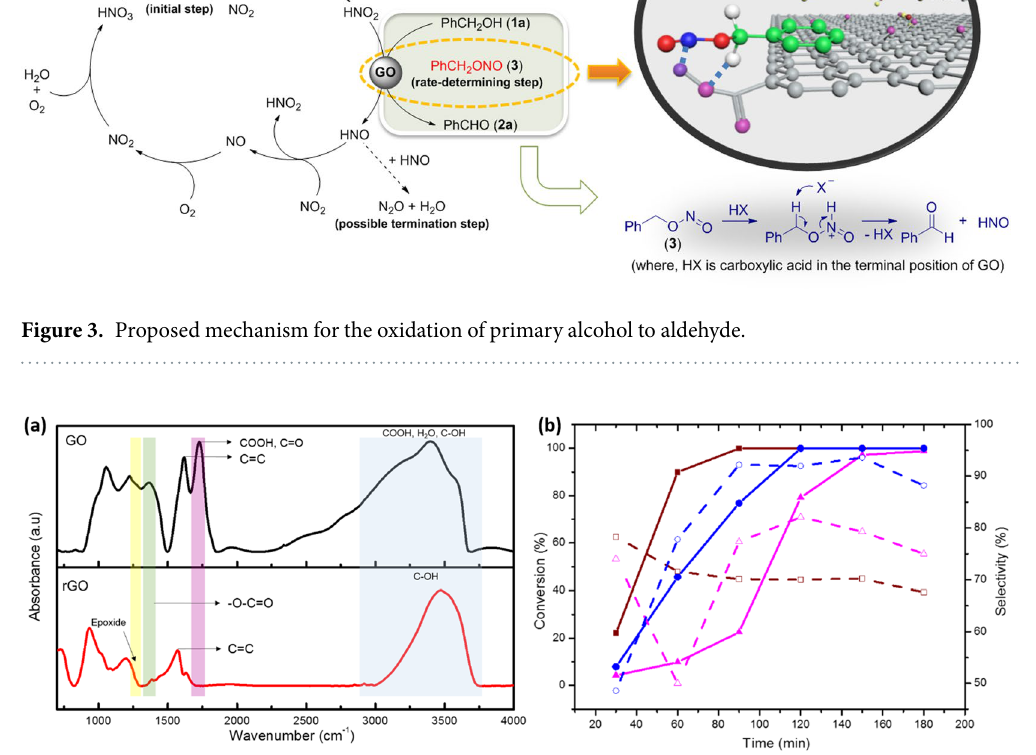
Figure 4. ( a ) FT-IR spectra of rGO and GO. ( b ) Solid line: conversion of alcohol; dotted line: selectivity for aldehyde (brown: rGO catalyst; blue: GO catalyst; pink: no